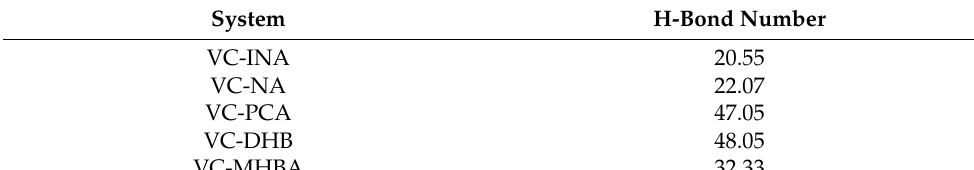
Table 3. Number of hydrogen bonds in VC-CCFs without water.